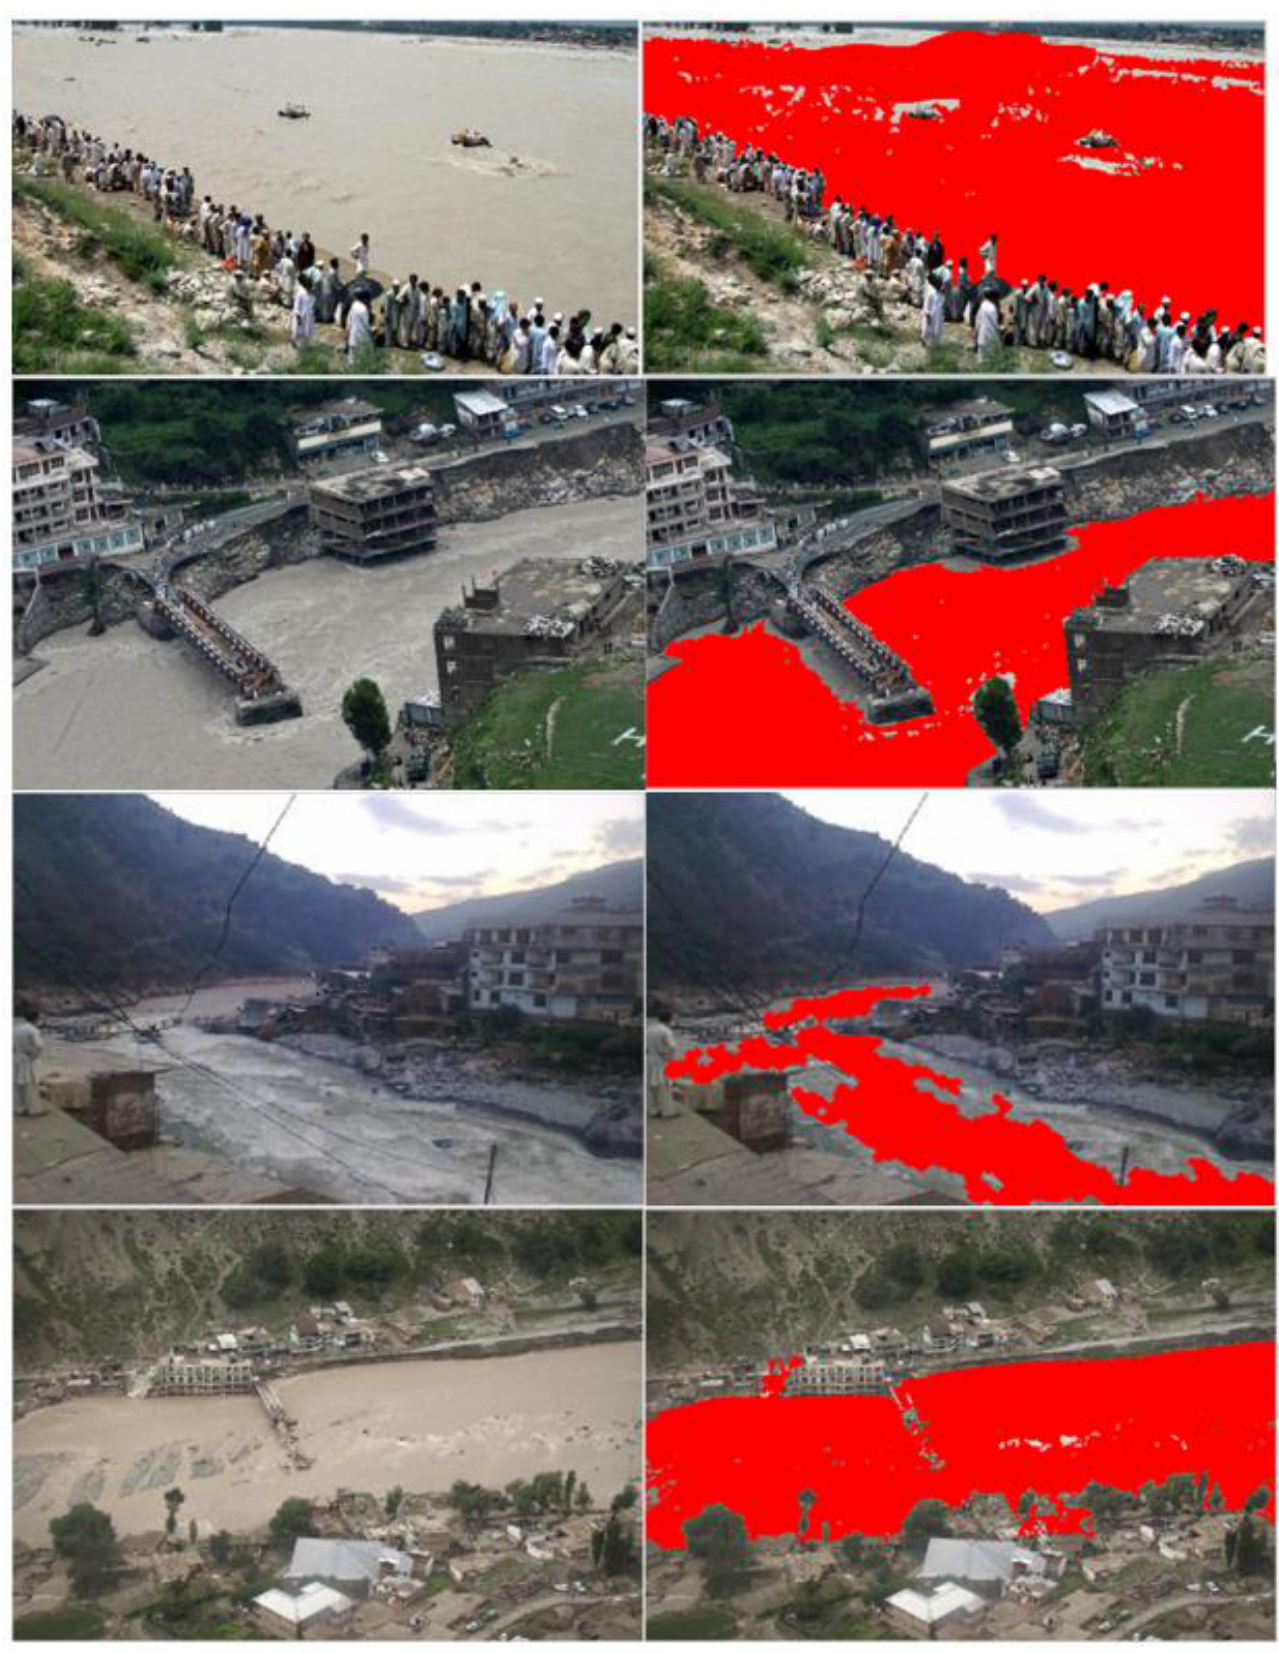
Figure 11. Flood mapping results on input test images.